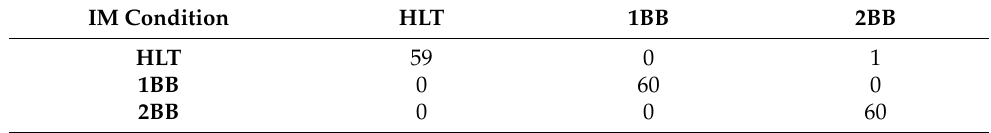
Table 1. Confusion matrix using Unser contrast definition for BRB detection and